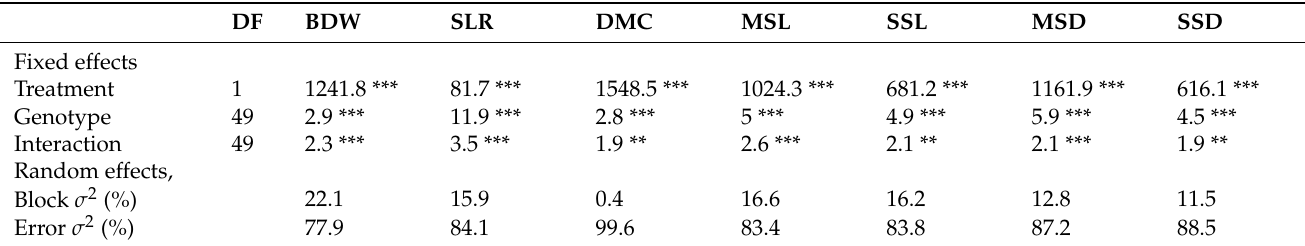
Table A2. Mixed-model ANOVA fixed-effects F-test statistics with significance levels and random effects variance components for treatment and genotype on biomass traits.